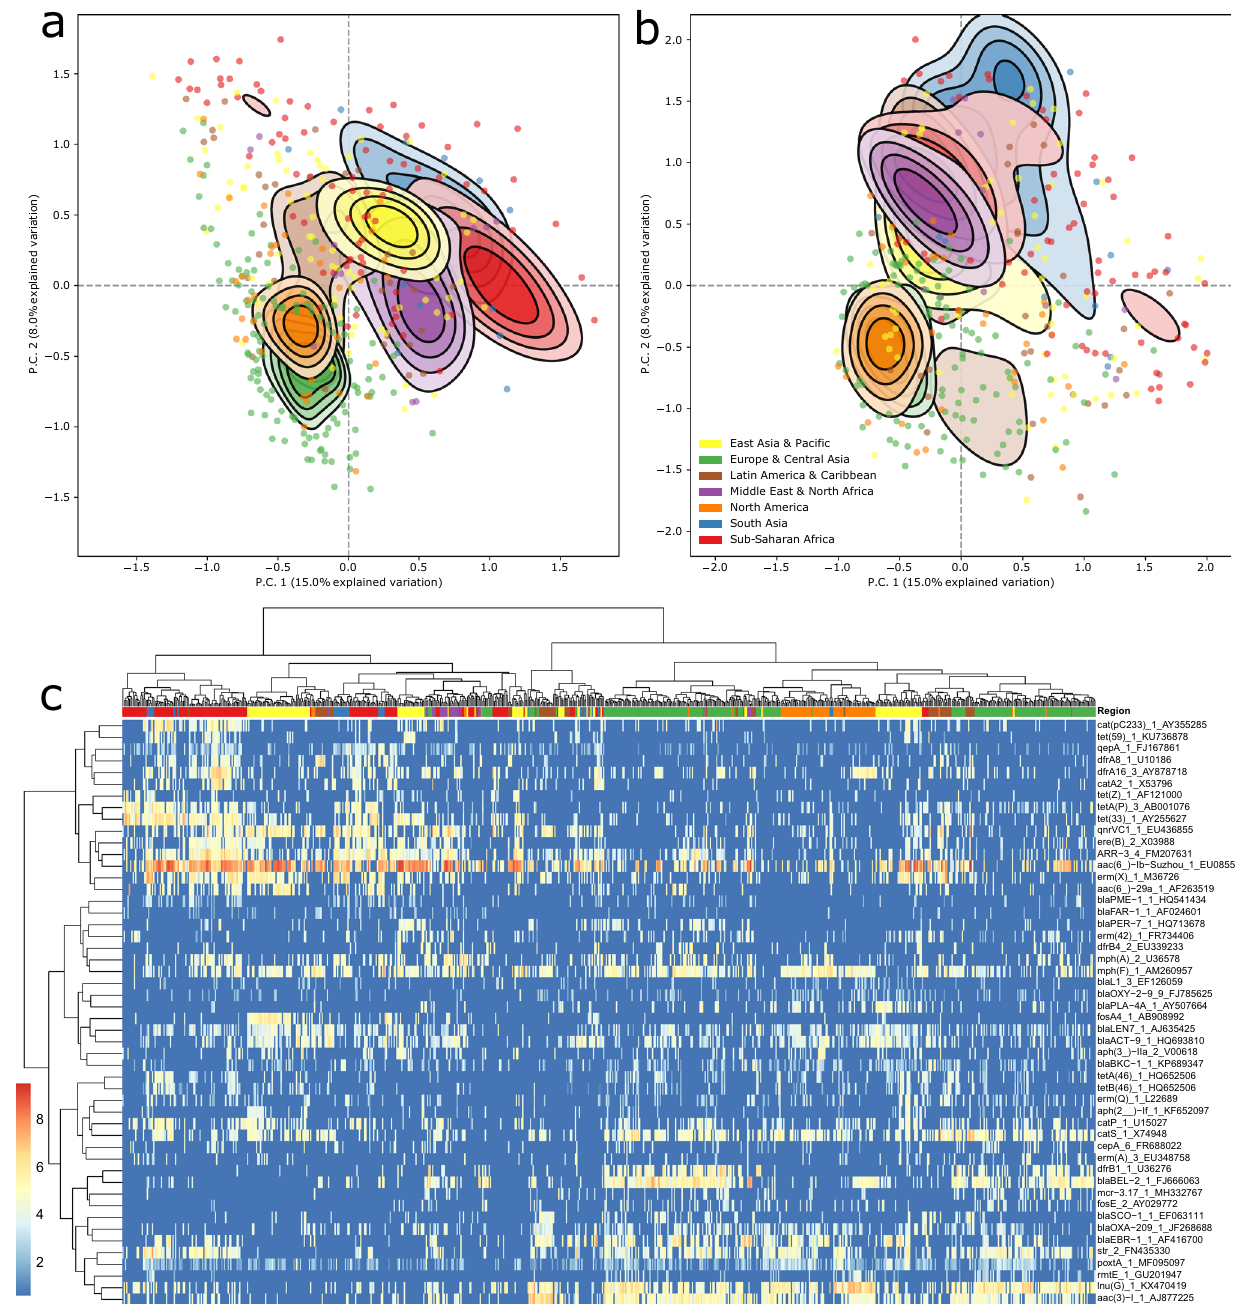
Fig.2|Worldregionaleffectsofbothbacteriomesandresistomes.a Resistance gene (90% homology grouping) PCA clustering. b Bacterial genus PCA clustering. The principal components in both panels are calculated from centered log-ratio (CLR)transformedsize-adjustedcounts.Thecontoursshowthegroup-wisesample density and are truncated at 50% of the peak value. Samples outside thisrange are